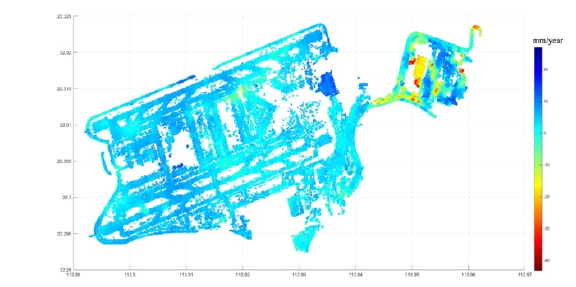
After screening the quality of candidate points, the selected points are used for generating time-series result.